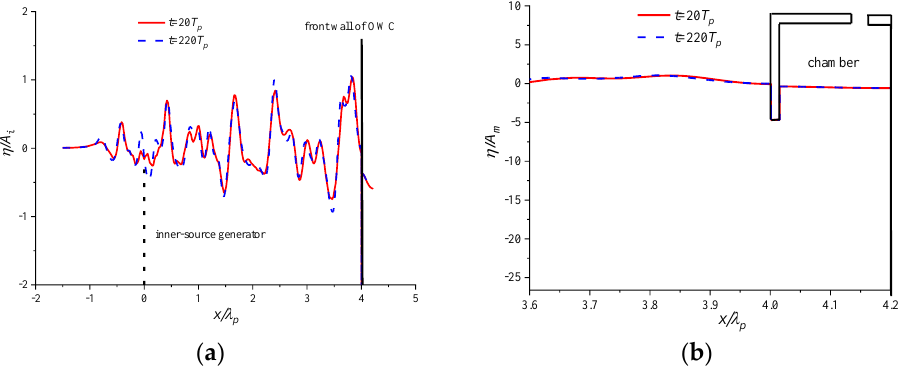
Figure 5. Profile of wave elevation along the numerical wave flume for T p = 1.366 s with t = 20 T p , and t = 220 T p . ( a ) Profile along the flume , ( b ) local view at the OWC chamber.